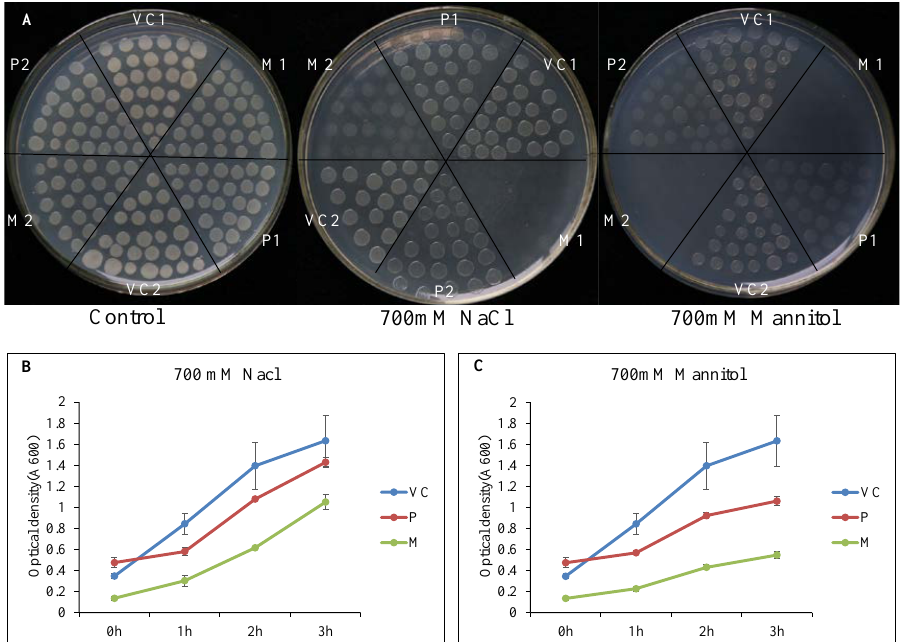
Figure 3. Expression of tomato HyPRP1 in Escherichia coli reduces abiotic stress tolerance. ( A ) Colony growth of E. coli cells harboring pET- SpHyPRP1 (P), pET- SlHyPRP1 (M), and pET-E1 (VC) under control (stress-free), salt (700 mM NaCl) and osmotic stress (700 mM mannitol) conditions in solid LB media. ( B ) Colony growth E. coli cells harboring P, M, and VC under salt in liquid LB media. ( C ) Colony growth E. coli cells harboring P, M, and VC under osmotic stress in liquid LB media.